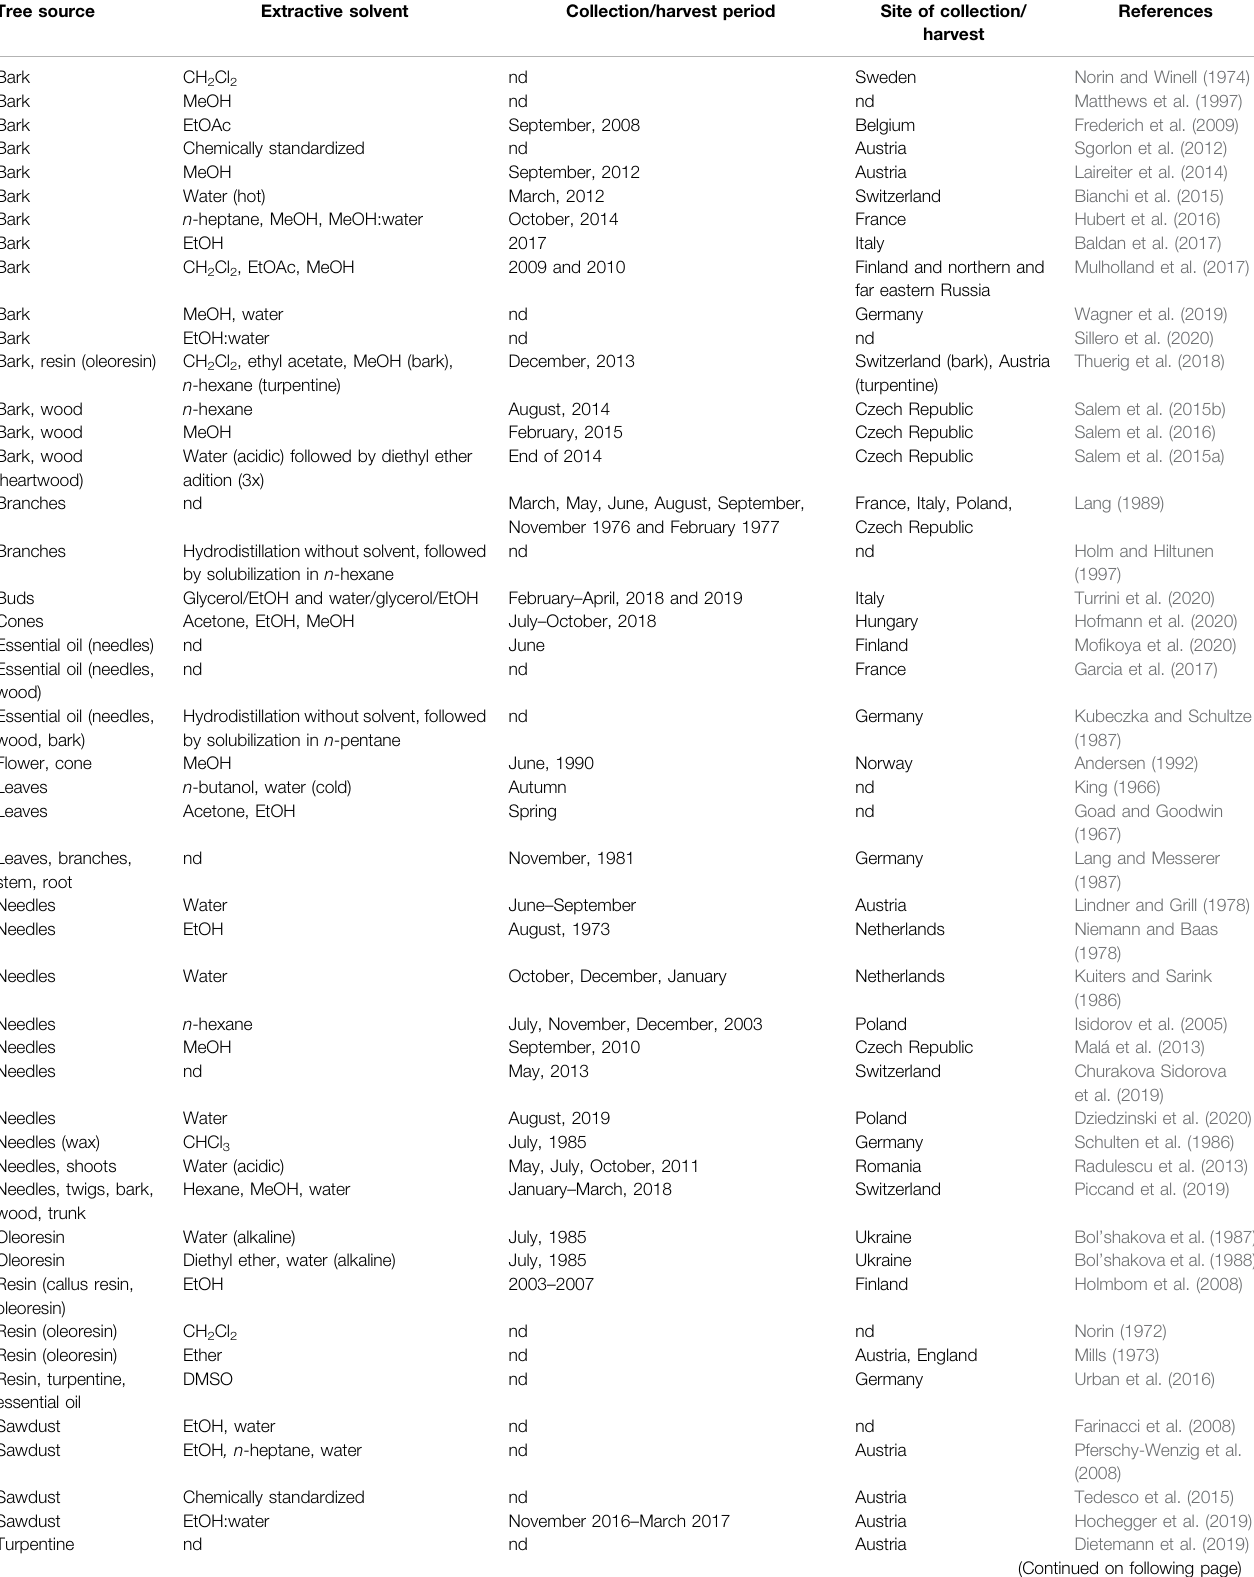
TABLE 1 | General overview over the 60 included articles in the